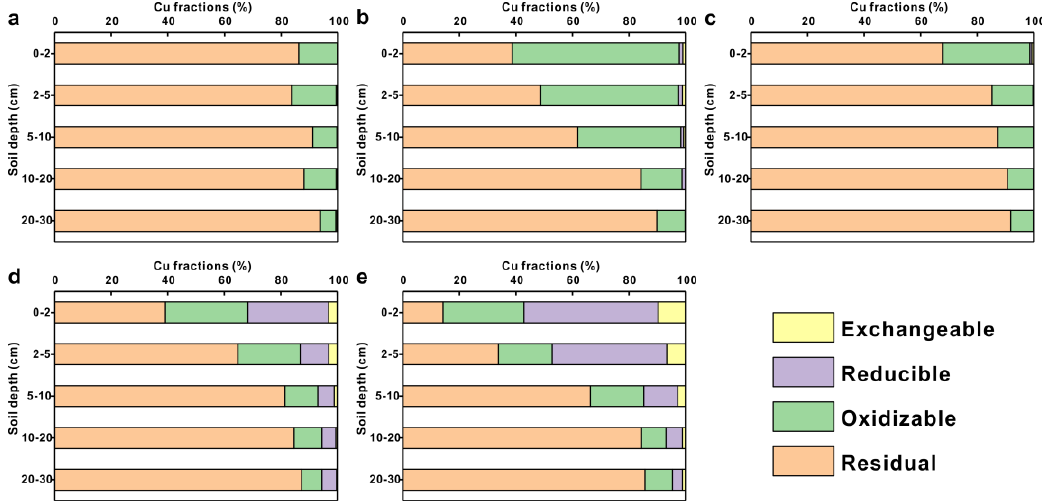
Figure 9. Percentage of exchangeable, reducible, oxidizable, and residual fractions of total Cu in soil profiles under different preservative – treated planks: ( a ) Background profile; ( b ) CCA-5; ( c ) ACQ-3; ( d ) CA-6; ( e ) CCA plus CA-3.